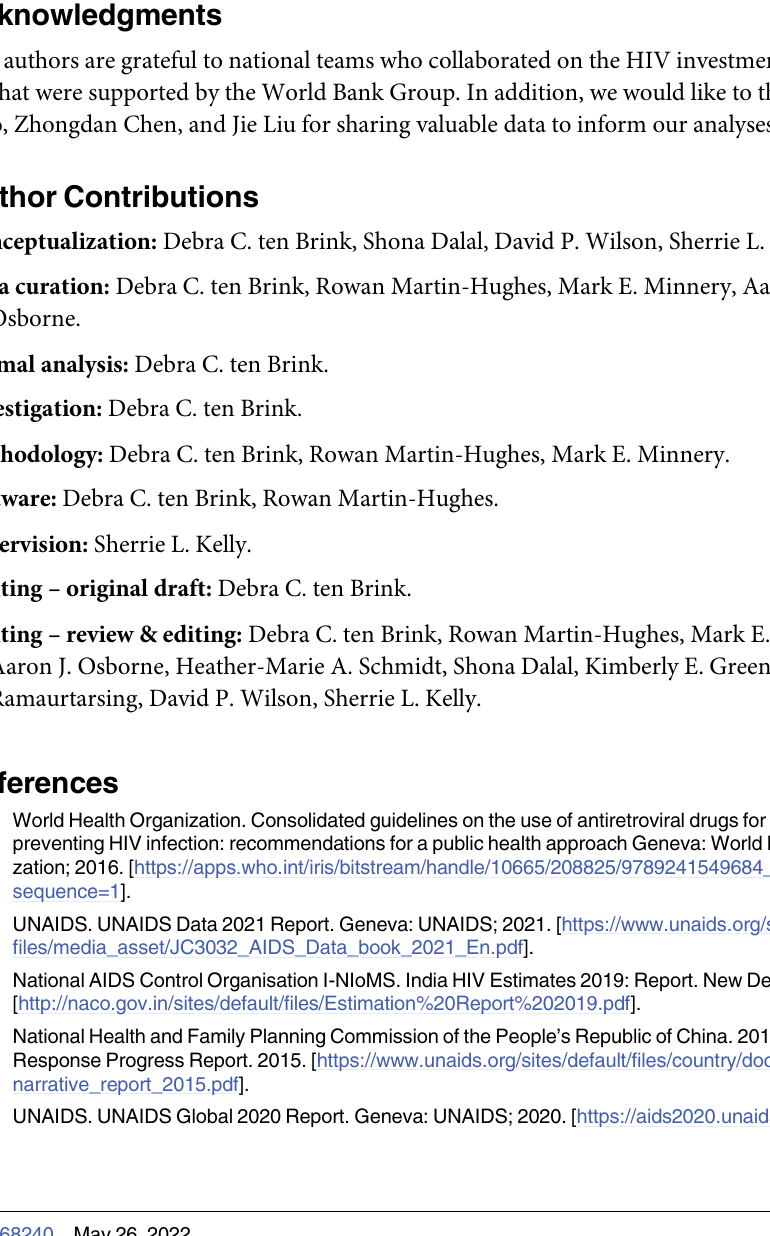
S1 Table. Latest reported key epidemiological model inputs. S2 Table. PrEP unit cost breakdown. S3 Table. ART unit